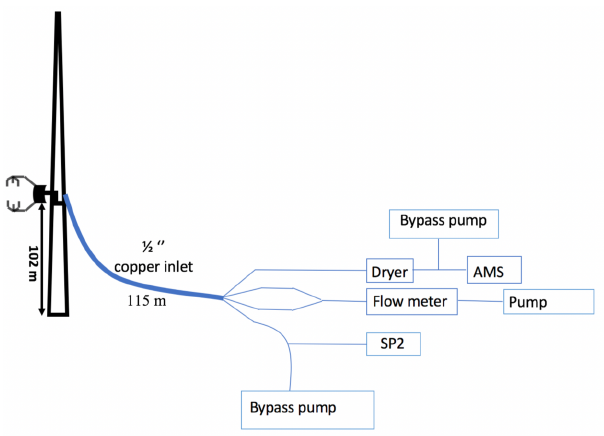
Figure 1. Eddy covariance (EC) measurement setup on the IAP tower for BC flux measurements. The aerosol and BC were sam- pled from an inlet placed at 102m above ground level. The sonic anemometer 0.75m from the inlet measured the wind components and virtual